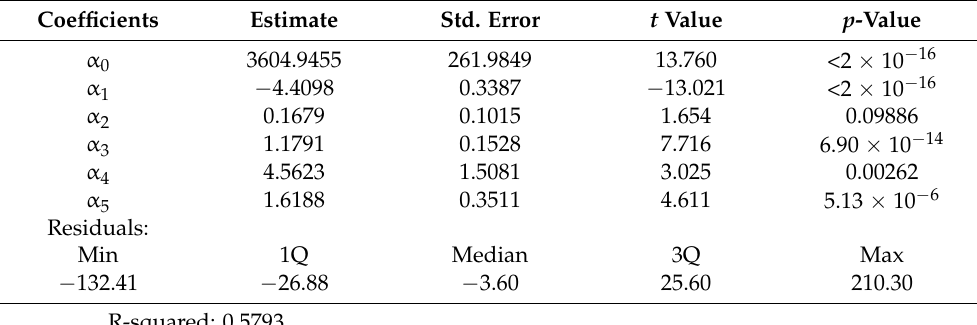
Figure A2. Both graphs with the test dataset. ( a ) The fitted values by the model and the pattern values for nitrogen dioxide; ( b ) the histogram of the net prediction errors of the model.